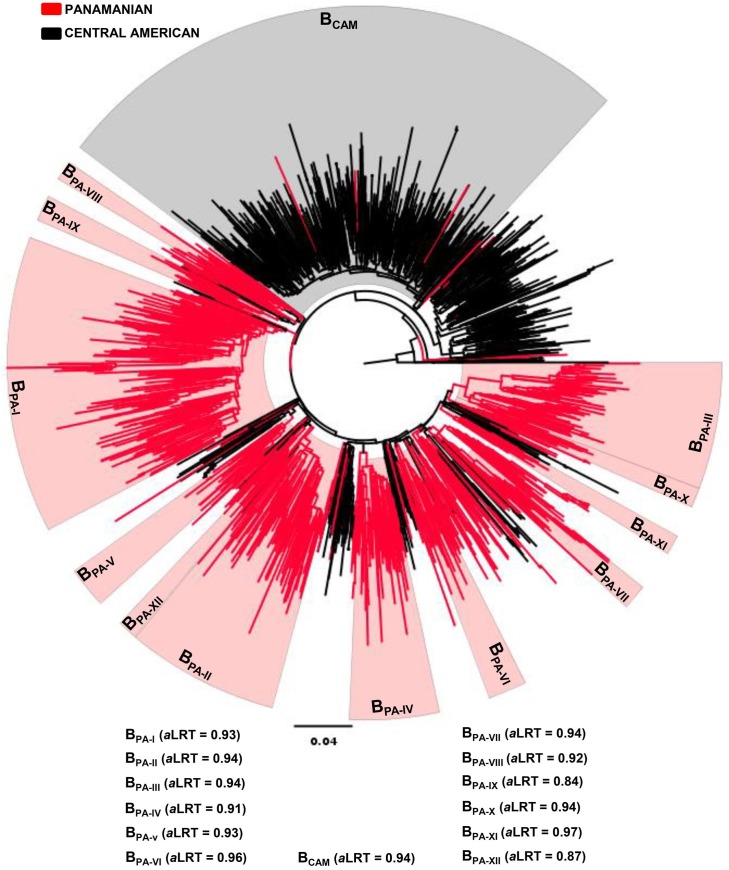
ML phylogenetic tree of HIV-1 subtype B pol (∼1000 pb) sequences circulating in Panama (n = 761) and other Central American countries (n = 694).The branches are colored according to the geographic origin of each sequence, as indicated at the legend (top left). Red shaded boxes highlight the position of the twelve Panamanian HIV-1 subtype B clades (BPA-I to BPA-XII). Gray shaded box highlights the position of the major Central American clade (BCAM). The aLRT support values for each clade are indicated at bottom. The tree was rooted using HIV-1 subtype D reference sequences. The branch lengths are drawn to scale with the bar at the bottom indicating nucleotide substitutions per site.